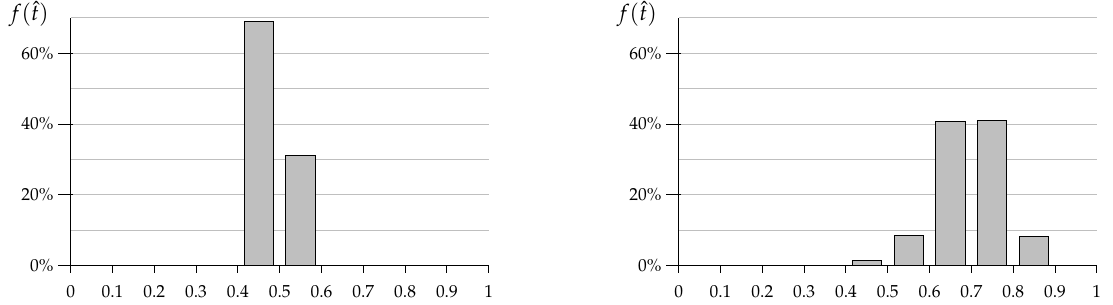
Figure 6. Distribution of shared thresholds under persistent invasions for “ALL imitate” (left) and “AVG imitate”